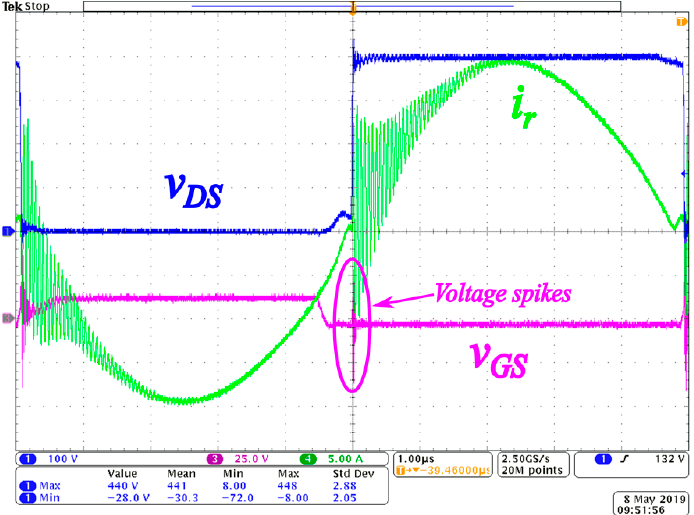
Figure 27. Experimental results without auxiliary circuit at 5 kW.